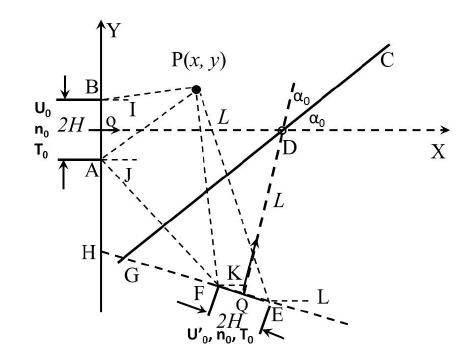
Figure 3. Free jet impingement on an inclined specular planar reflective plate. (cid:54) PBI = θ 1 , (cid:54) PAJ = θ 2 ,